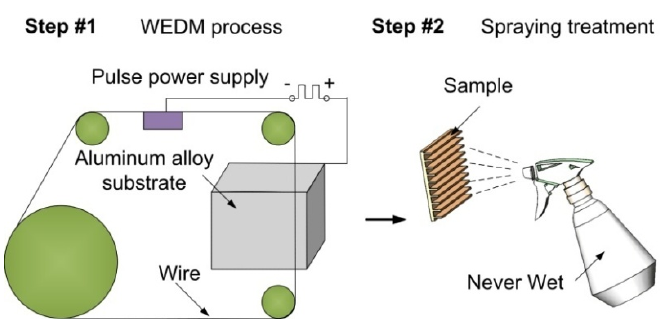
Figure 1. Illustration of the entire fabrication process.